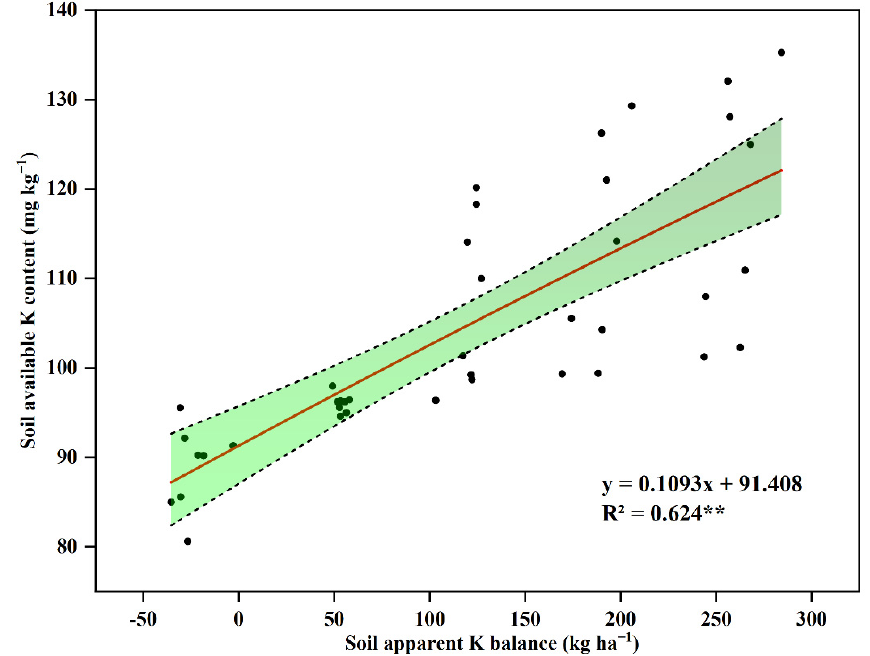
Figure 5. Relationship between soil apparent K balance and soil available K content. Linear regression is shown as a red solid line and dashed curve represents 95% confidence intervals (CI). ** Significant at the 0.01 probability level.